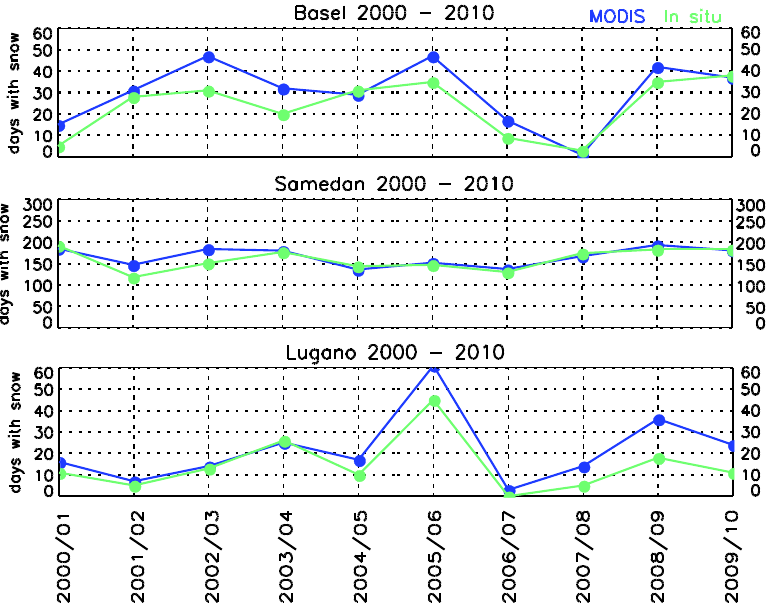
Fig. 2. Temporal variability of the total yearly number of snow days from 2000–2010 for Basel (Swiss Plateau), Samedan (Central Alps) and Lugano (Southern Alps) in Switzerland. Table 2. SCD MODIS versus SCD in situ on a yearly basis ( d =mean absolute difference of SCD MODIS − SCD in situ , s =standard deviation, c =coefficient of correlation, d (%)=relative difference). SCD in situ indicates the averaged number of days with snow over the 10yr and cc is the averaged annual cloud cover in percent derived from the MOD10C1